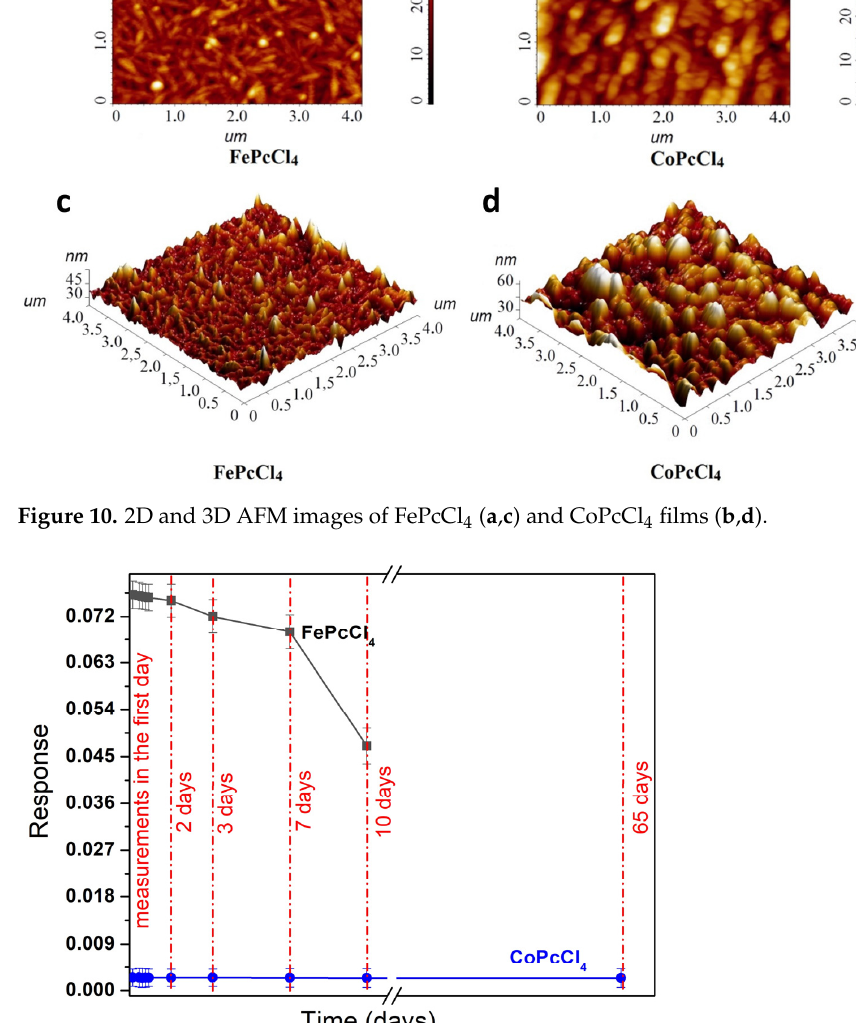
Figure 11. Change of the sensor response of FePcCl 4 and CoPcCl 4 films to NO (30 ppb) over time.